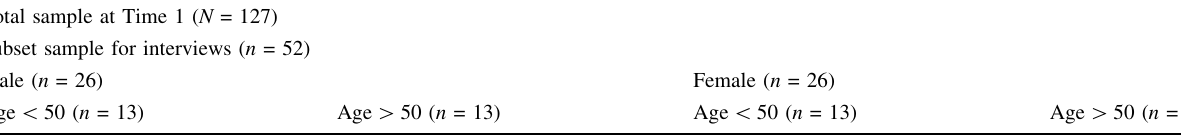
Table 1 Matched stratified sample of participants in the qualitative component of the study in Amatrice, Central Italy, after the 2016–2017 earthquakes Total sample at Time 1 ( N = 127)